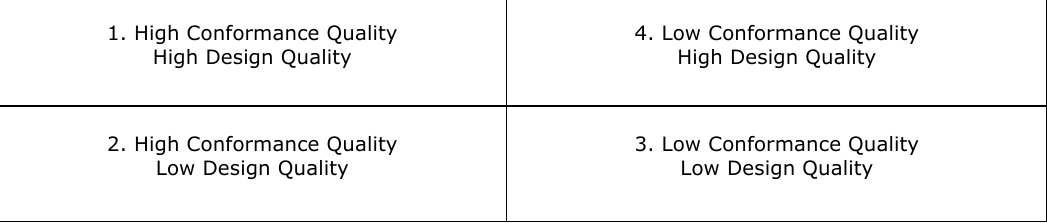
Table 1. “Combinations of quality